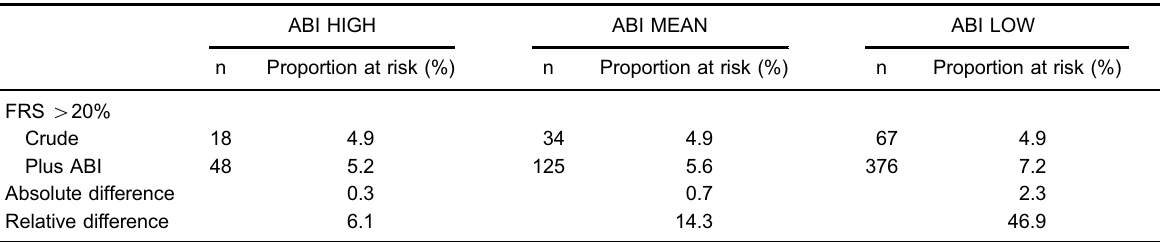
Table 5. Participants with a 10-year Framingham risk score (FRS) greater than 20% with and without the addition of ankle-brachial index (ABI) o 1.0 as high